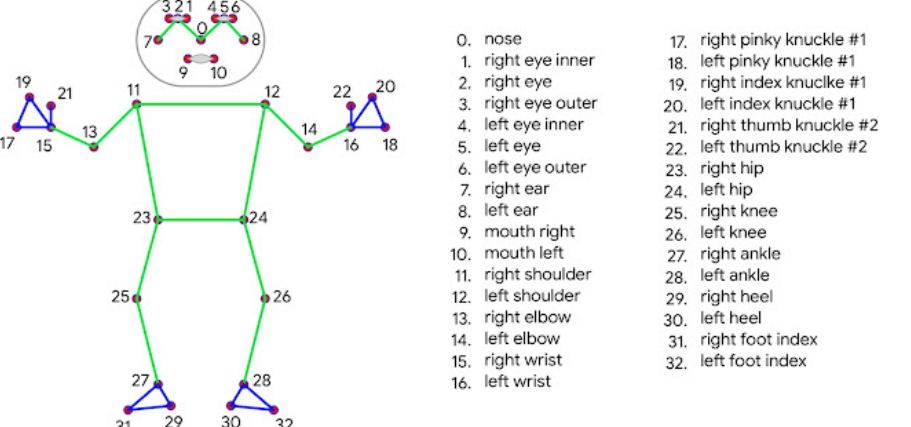
Figure 9. List of 33 markers used by MediaPipe and their position in the human body to estimate their pose